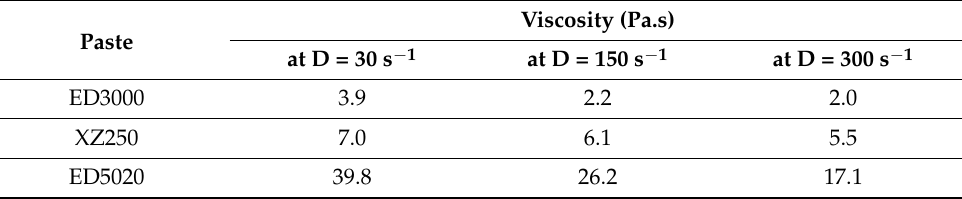
Table 2. Measured viscosities of ED3000, XZ250, and ED5020 pastes at 25 ◦ C.